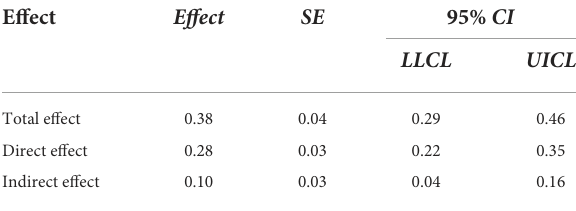
TABLE 4 Bootstrap analysis of mediation effect significance test ( N =